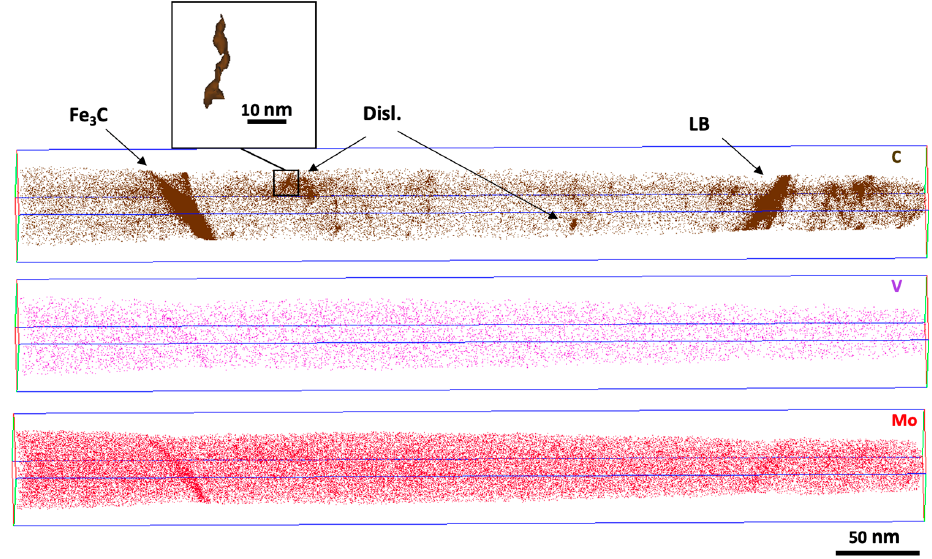
Figure 3. Maps of all C, V, and Mo atoms in the quenched material. An Fe 3 C carbide ( left ) and segregation to a slightly curved lath boundary (LB) can be seen ( right ). There are also some very small carbon enrichments in the matrix. Some of these are elongated along presumed dislocations, as shown in the ( rotated ) insert, which shows an isosurface of 1.2 at% C.